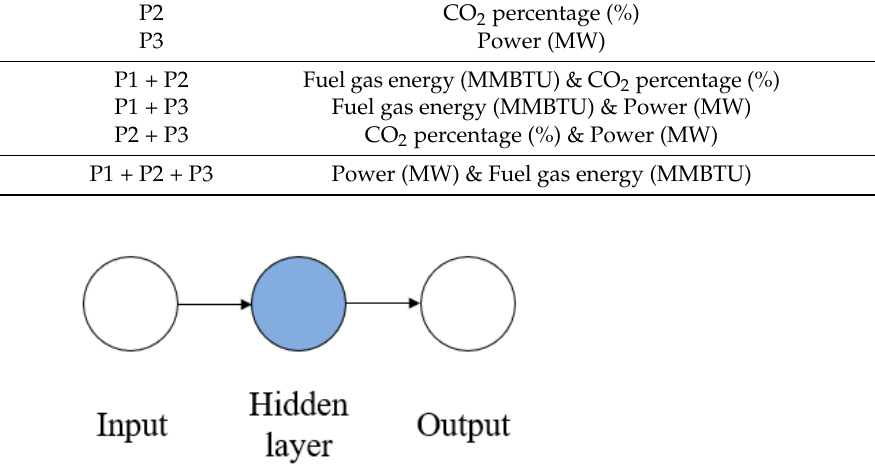
Figure 2. ANN structure for one input parameter (P1, P2 and P3). Two input parameters were combined as presented in the Table 2. In these models, two hidden layers were used. The first hidden layer used four neurons as a rule of thumb of the hidden layer as the input layer square, and the second hidden layer used 1 neuron. The transfer function used in the first hidden layer was tansig, and the second hidden layer used purelin as a transfer function. The ANN structure for the model with two input parameters is shown in Figure